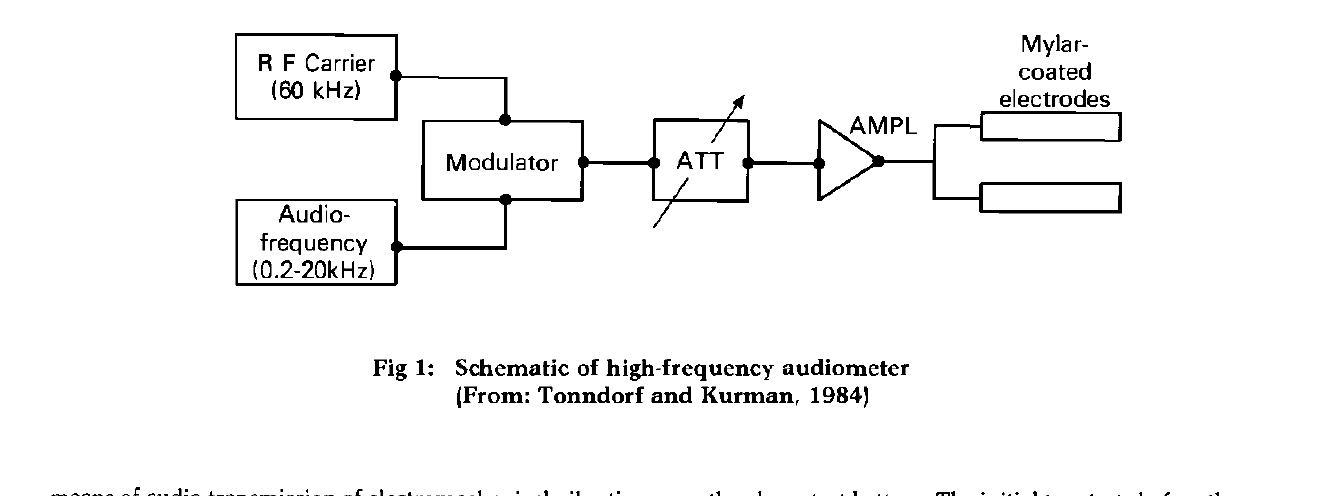
Fig 1: Schematic of high-frequency audiometer (From: Tonndorf and Kurman,